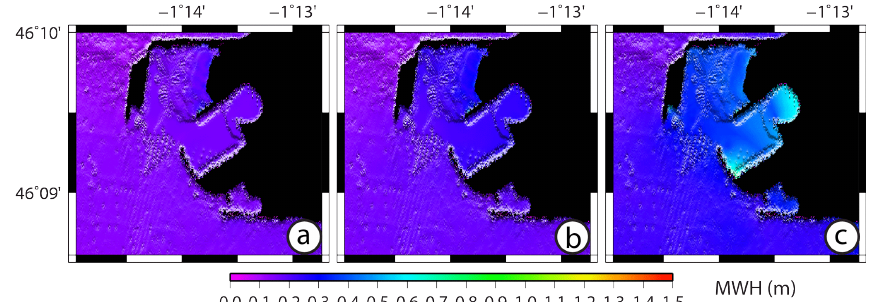
Figure 11. Maximum wave height maps for the trade port of la Rochelle (grid 9) obtained after 12h of propagation for the 3 scenarios. From left to right, scenarios 1 (a) , 2 (b) , and 3 (c)